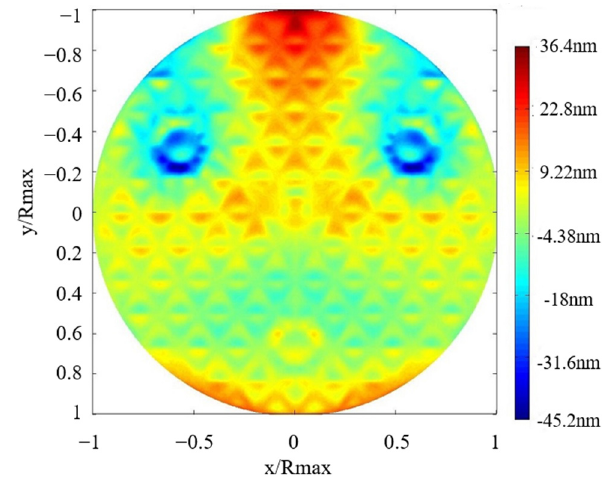
Figure 11. Mirror surface error cloud picture.